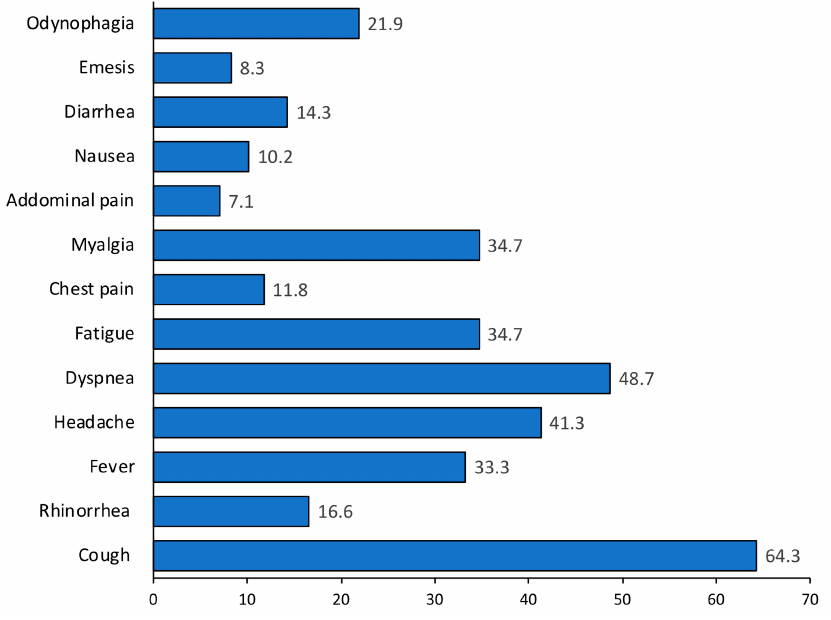
Figure 1. Prevalence of clinical symptoms in COVID-19